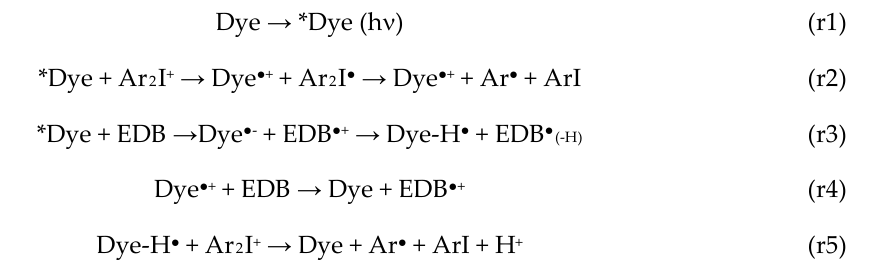
Figure 6. Consumption of dyes vs. irradiation time upon irradiation with a LED@405 nm ( a ) dye 5 /Iod/amine(  ); dye 5 /Iod(●); dye 5/ amine(  ). ( b ) dye 9 /Iod/amine(  ); dye 9 /Iod(●); dye 9 /amine(  ). ( c ) dye 17 /Iod/amine(  ); dye 17 /Iod(●); dye 17 /amine(  ). ( d ) dye 19/ Iod/amine(  ); dye 19 /Iod(●); dye 19 /amine( 